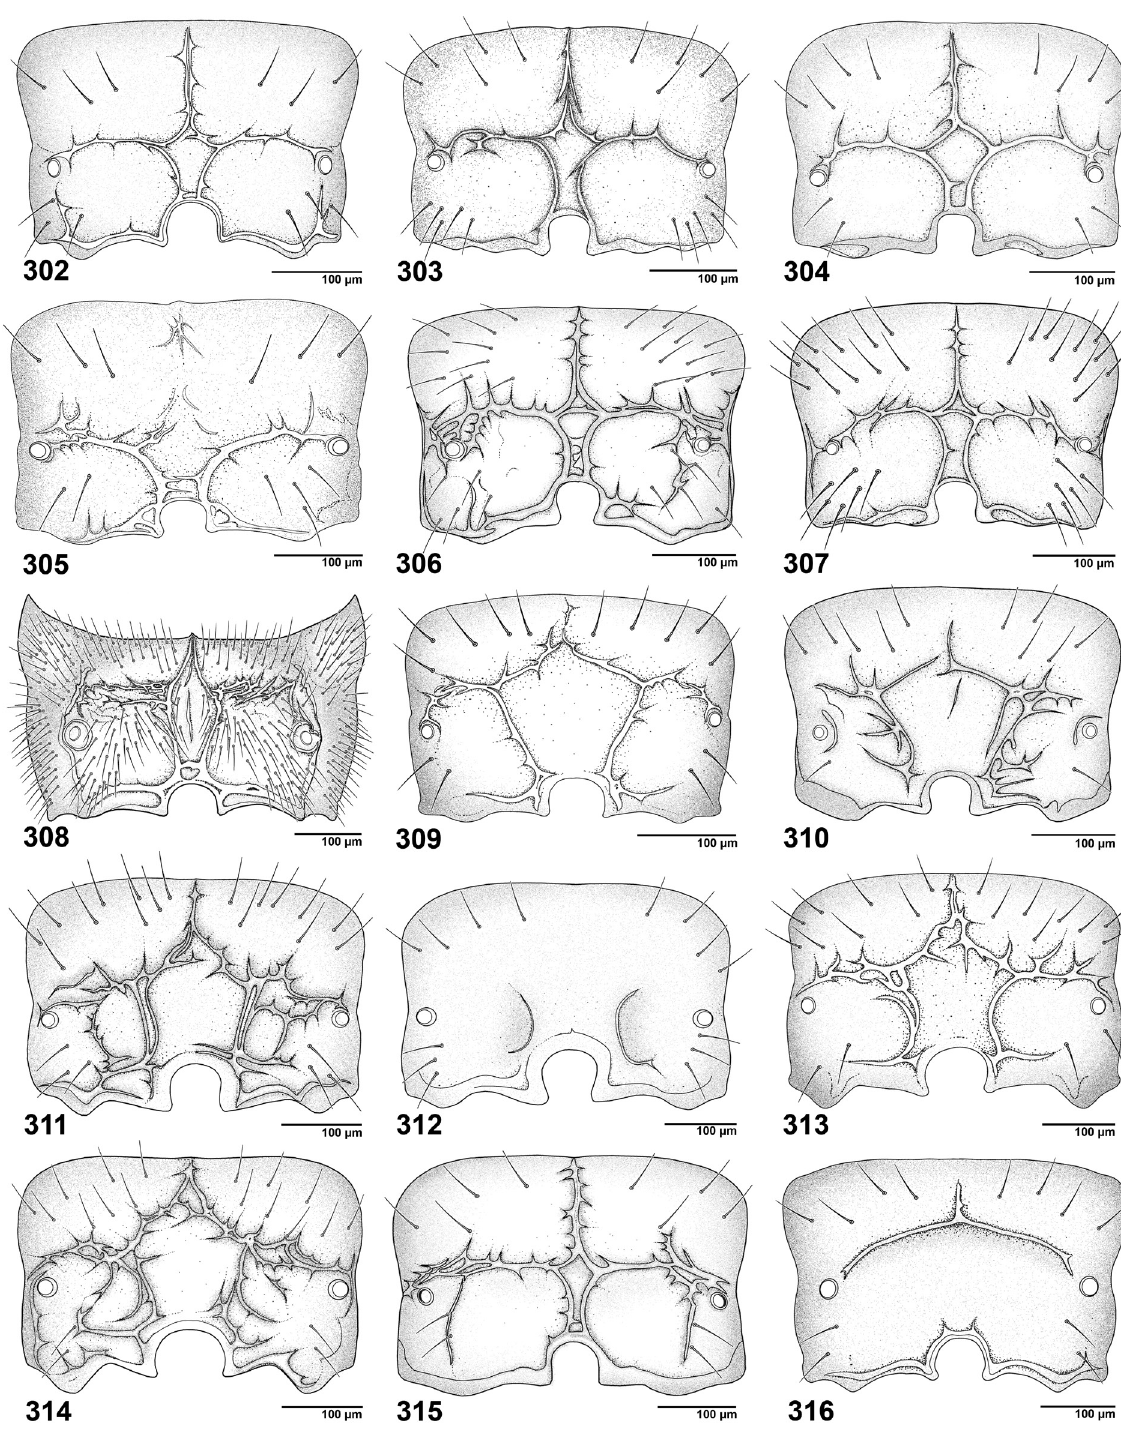
Figs 302–316. Dorsal aspect of propodeum (♀): 302 . Aphidius sonchi . 303 . Aphidius stigmaticus . 304 . Aphidius transcaspicus . 305 . Aphidius uroleuci . 306 . Aphidius urticae . 307 . Aphidius uzbekistanicus . 308 . Areopraon lepelleyi . 309 . Betuloxys hortorum . 310 . Binodoxys acalephae . 311 . Binodoxys angelicae . 312 . Binodoxys brevicornis . 313 . Binodoxys centaureae . 314 . Binodoxys heraclei . 315 . Diaeretiella rapae . 316 . Diaeretus leucopterus